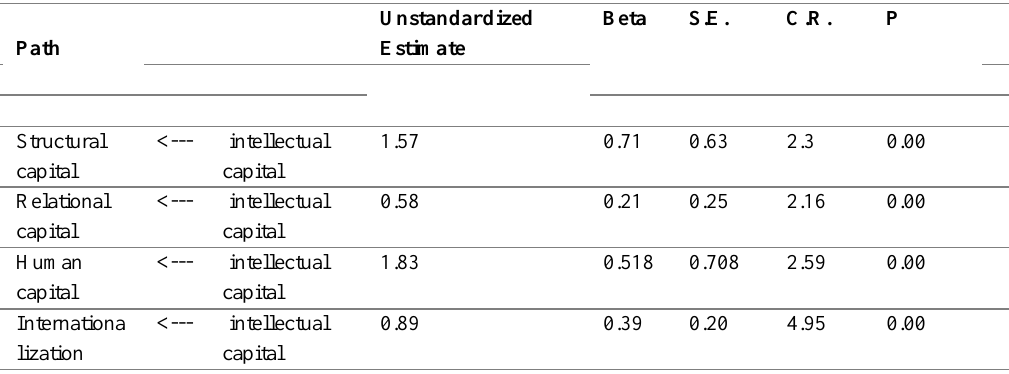
Table 2: Path coefficients for intellectual